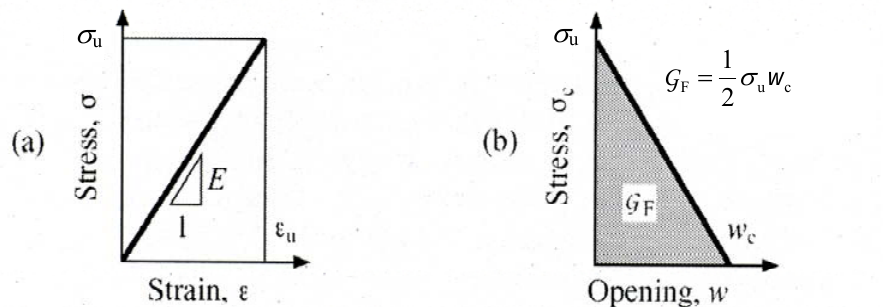
Figure 1: Constitutive laws of the cohesive crack model: (a) undamaged material; (b) process zone.